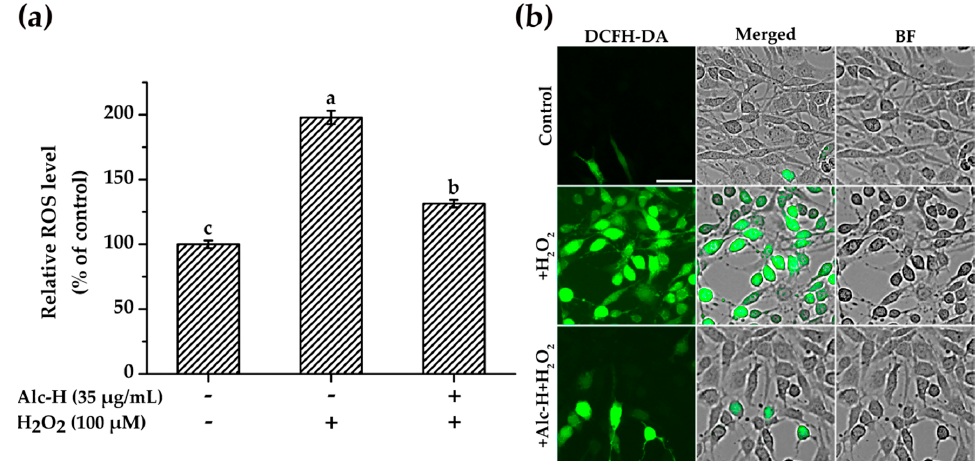
Figure 4. Effects of alcalase hydrolysate (Alc-H) on H 2 O 2 -induced intracellular reactive oxygen species (ROS) accumulation in PC12 cells. ( a ) Fluorescent intensity of ROS inside the cells. PC12 cells were pretreated with Alc-H (35 μ g/mL) for 12 h before being exposed to 100 μ M H 2 O 2 for 1 h. Data are expressed as mean ± SD ( n = 4). Bars with different alphabets indicate statistically significant difference between the means ( p < 0.05). ( b ) Fluorescent images of ROS inside the cells were captured by Cytation 5 fluorescent cell imager. Cells were pretreated with Alc-H (35 μ g/mL) for 12 h before stimulation with 100 μ M H 2 O 2 for 1 h. Bar = 50 μ m.